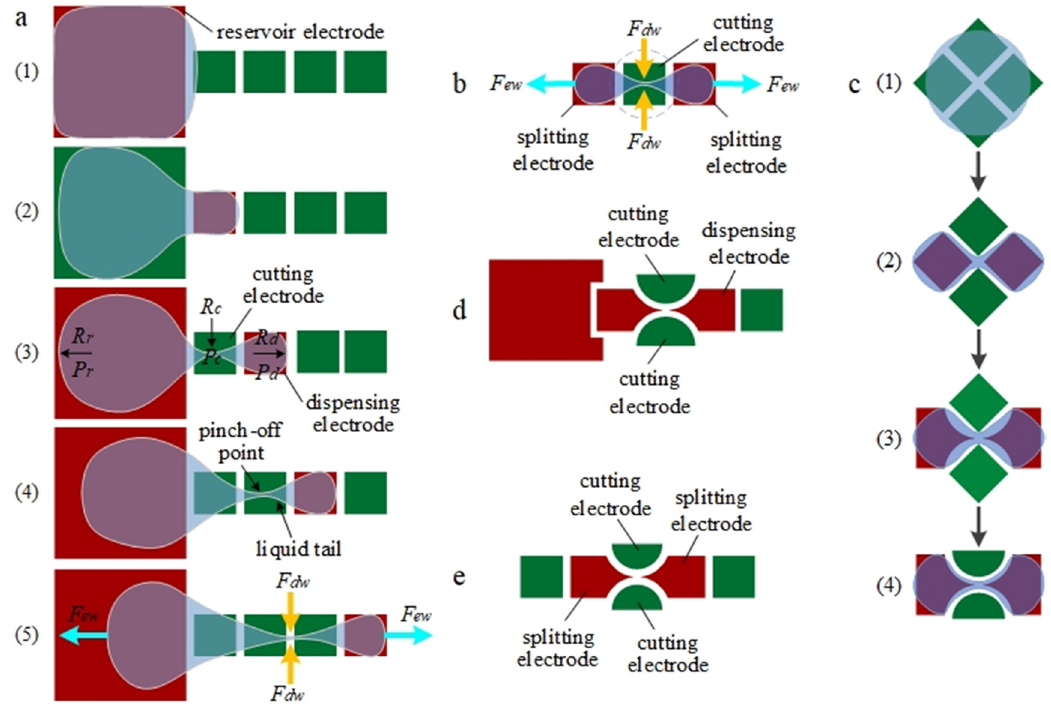
Figure 2: Droplet dispensing and splitting scheme. ( a and b ) Traditional dispensing and splitting scheme with square electrodes. ( c ) Ideal droplet separation concept and its evolution. ( d ) Optimized droplet dispensing scheme. ( e ) Optimized splitting schemes. The activated electrode is shown in red, while the deactivated electrode is shown in